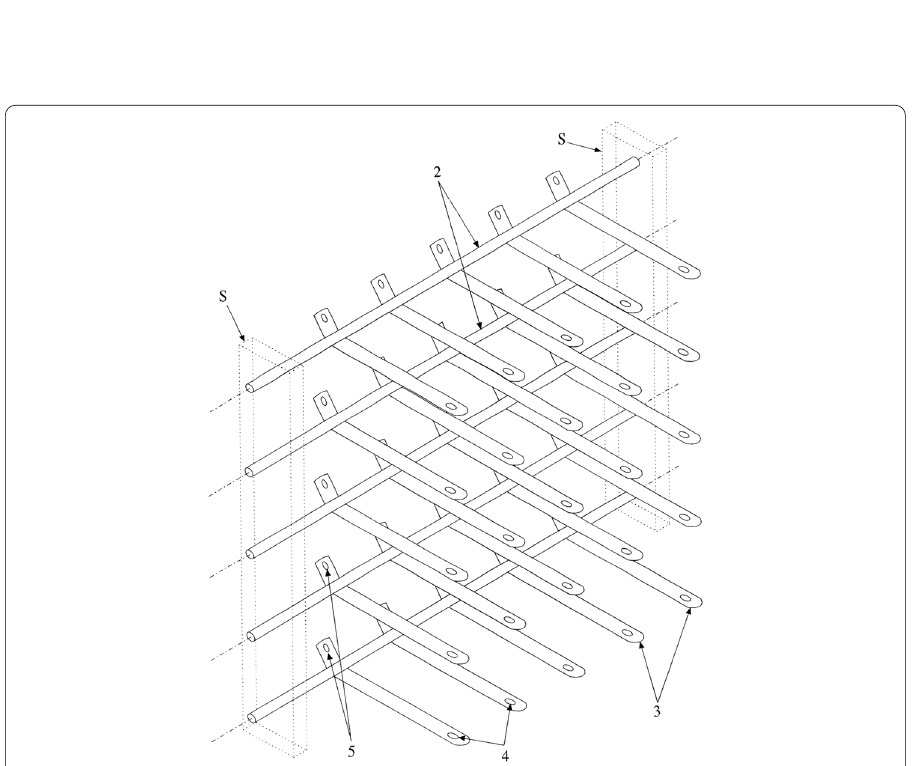
Fig. 6 Heald shaft arrangement in linear–angular method of dual-directional shedding (Khokar 2002c). 2— heald shafts, 3—flat healds, 4—heald eye, 5—heald guide,